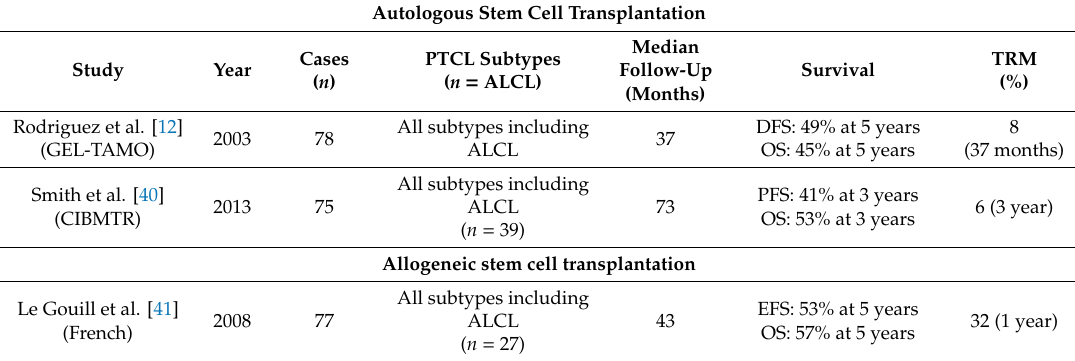
Table 5. Autologous and allogeneic stem cell transplantation in the relapsed and refractory setting: Registry